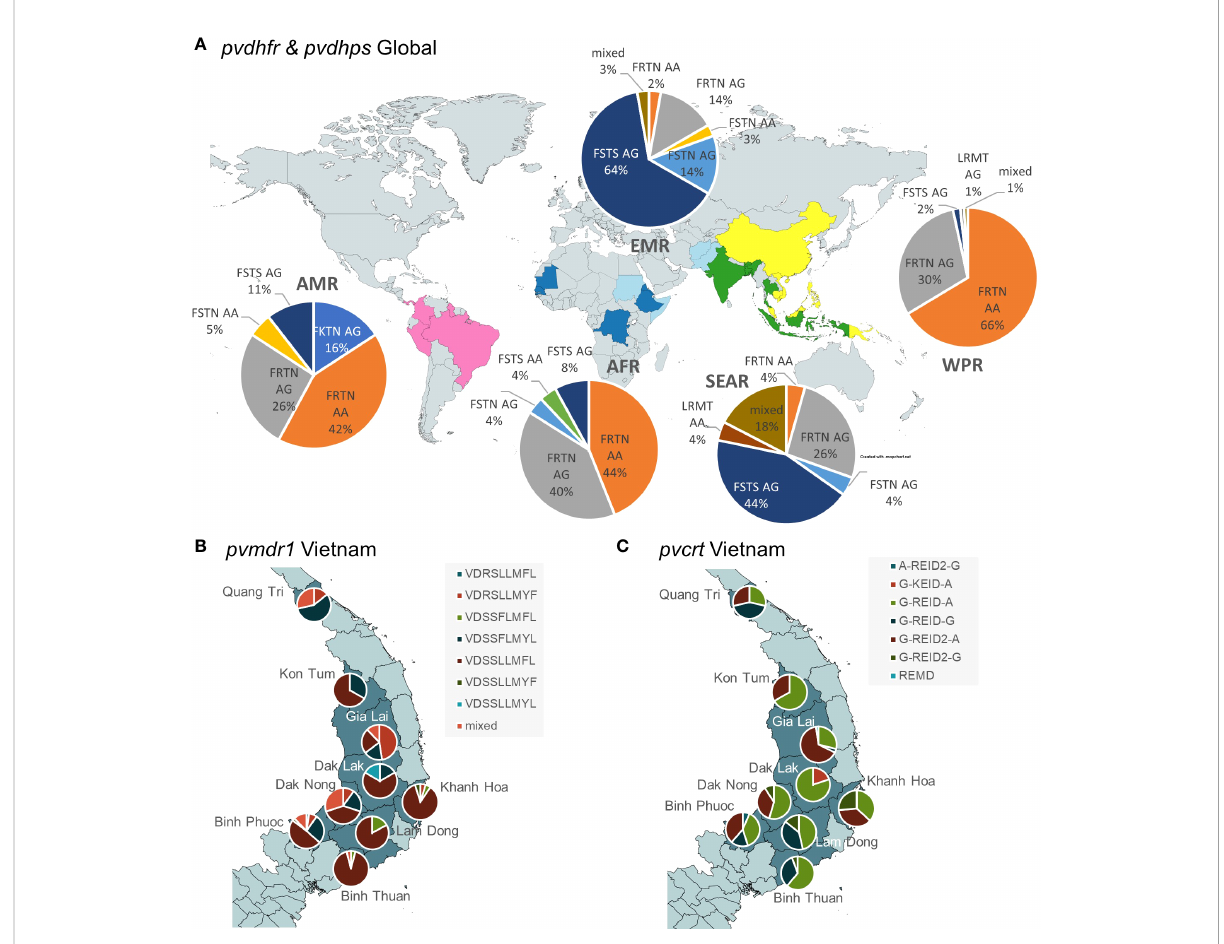
FIGURE 6 Geographical separation of selected haplotypes in drug resistance associated genes genotyped by Pv AmpliSeq assay. (A) Global spread of pvdhps and pvdhfr validated mutations for SP resistance (dhfr: F57L,S58R/K,T61M,N117T/S; dhps: A383G, A553G). Map background created in https://www.mapchart.net/ (B) Spread of pvmdr1 haplotypes (V221L, D500N, S513R, S698G, L845F, L908M, T958M, Y976F, F1076L) and (C) pvcrt haplotypes (intron 357 + 83G>A, R121K, E207Q, I319M, D328D(A>G), intron 1003-46G>A) at a provincial level in Central Vietnam. Background map created in QGIS v3.16 with spatial data from